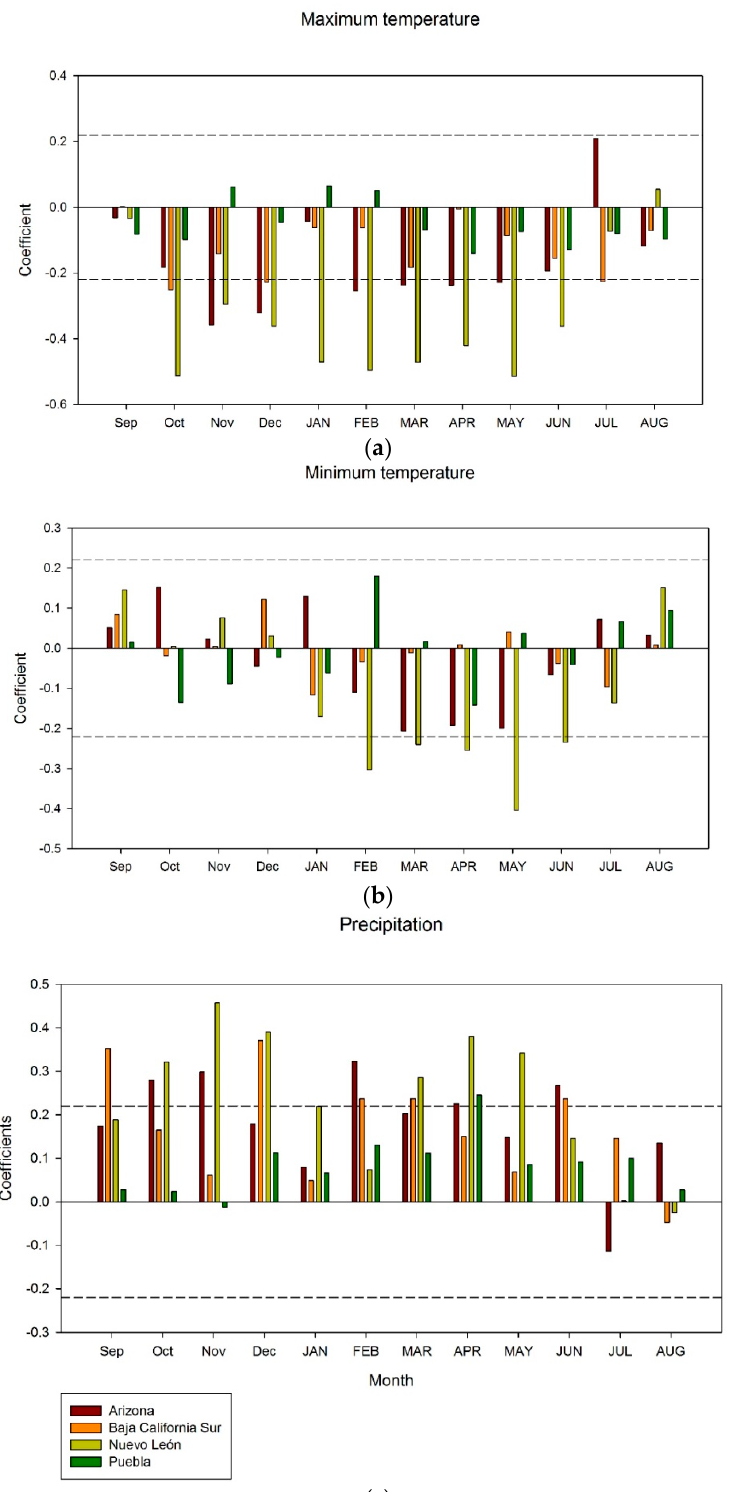
Figure 3. Climate-growth associations (Pearson correlation coefficients) of study areas with respect to the following climatic variables. Mean maximum temperature ( a ), mean minimum temperature ( b ), and precipitation ( c ). The months of the previous year are labeled in lower case letters and those of the current year in upper case letters. Significant correlations ( p < 0.05) correspond to values located above ( r > 0.22) or below ( r < − 0.22) the dashed horizontal lines.